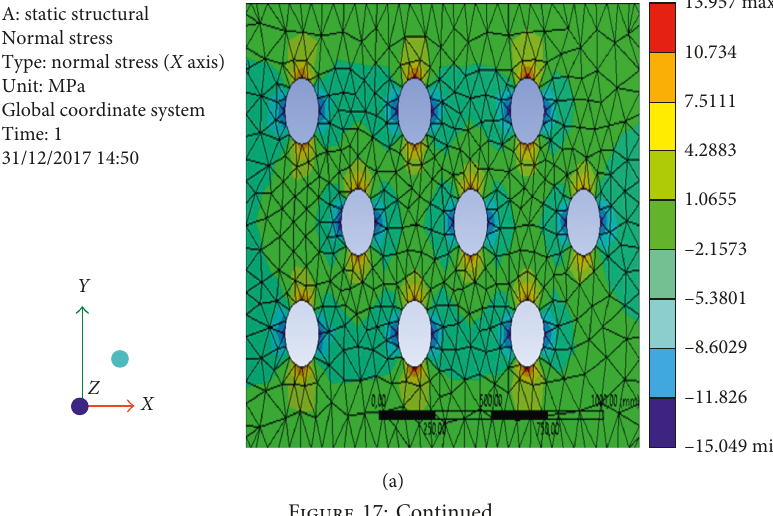
A: static structural Normal